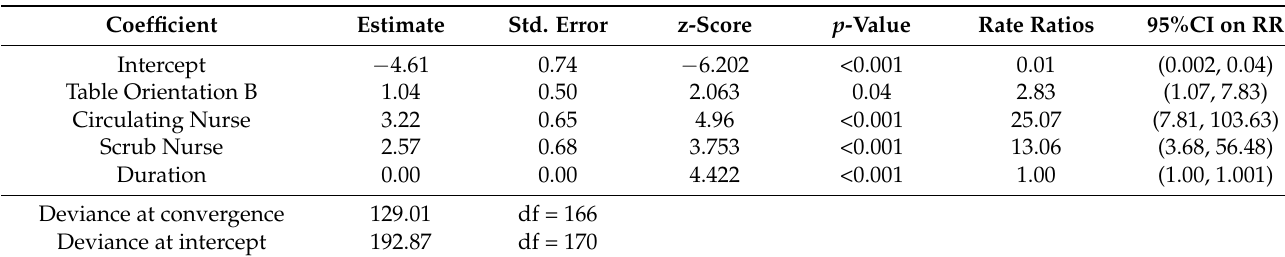
Table 8. Logistic regression predicting the likelihood that an individual was in the fourth quartile of distanced moved during the intraoperative phase.